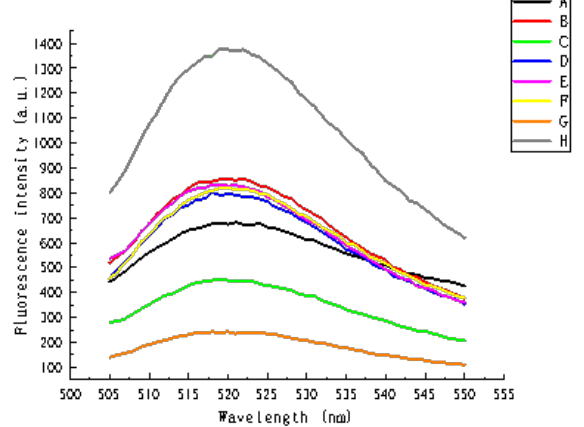
Figure 2. Fluorescence spectra in the absence of sensing system components: ( A ) without miRNA, ( B ) without padlock probes, ( C ) without dNTPs, ( D ) without H1 and H2, ( E ) without Mg 2+ , ( F ) without polymerase, ( G ) without ligase and ( H ) control sample (experimental system in which all the above components exist).